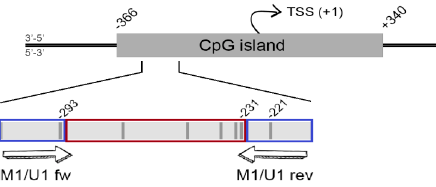
Figure 1. Schematic presentation of promoter area of the SRXN1 gene encompassing investigated CpG island. Primer binding sites are shown in the inset with CpG dinucleotides marked as short vertical lines. The TSS location is marked as “+1”; M1/U1 fw, methylated and unmethylated forward primers, respectively; M1/U1 rev, methylated and unmethylated reverse primers, respectively. Blue outlining indicates regions investigated with MSP, whereas red